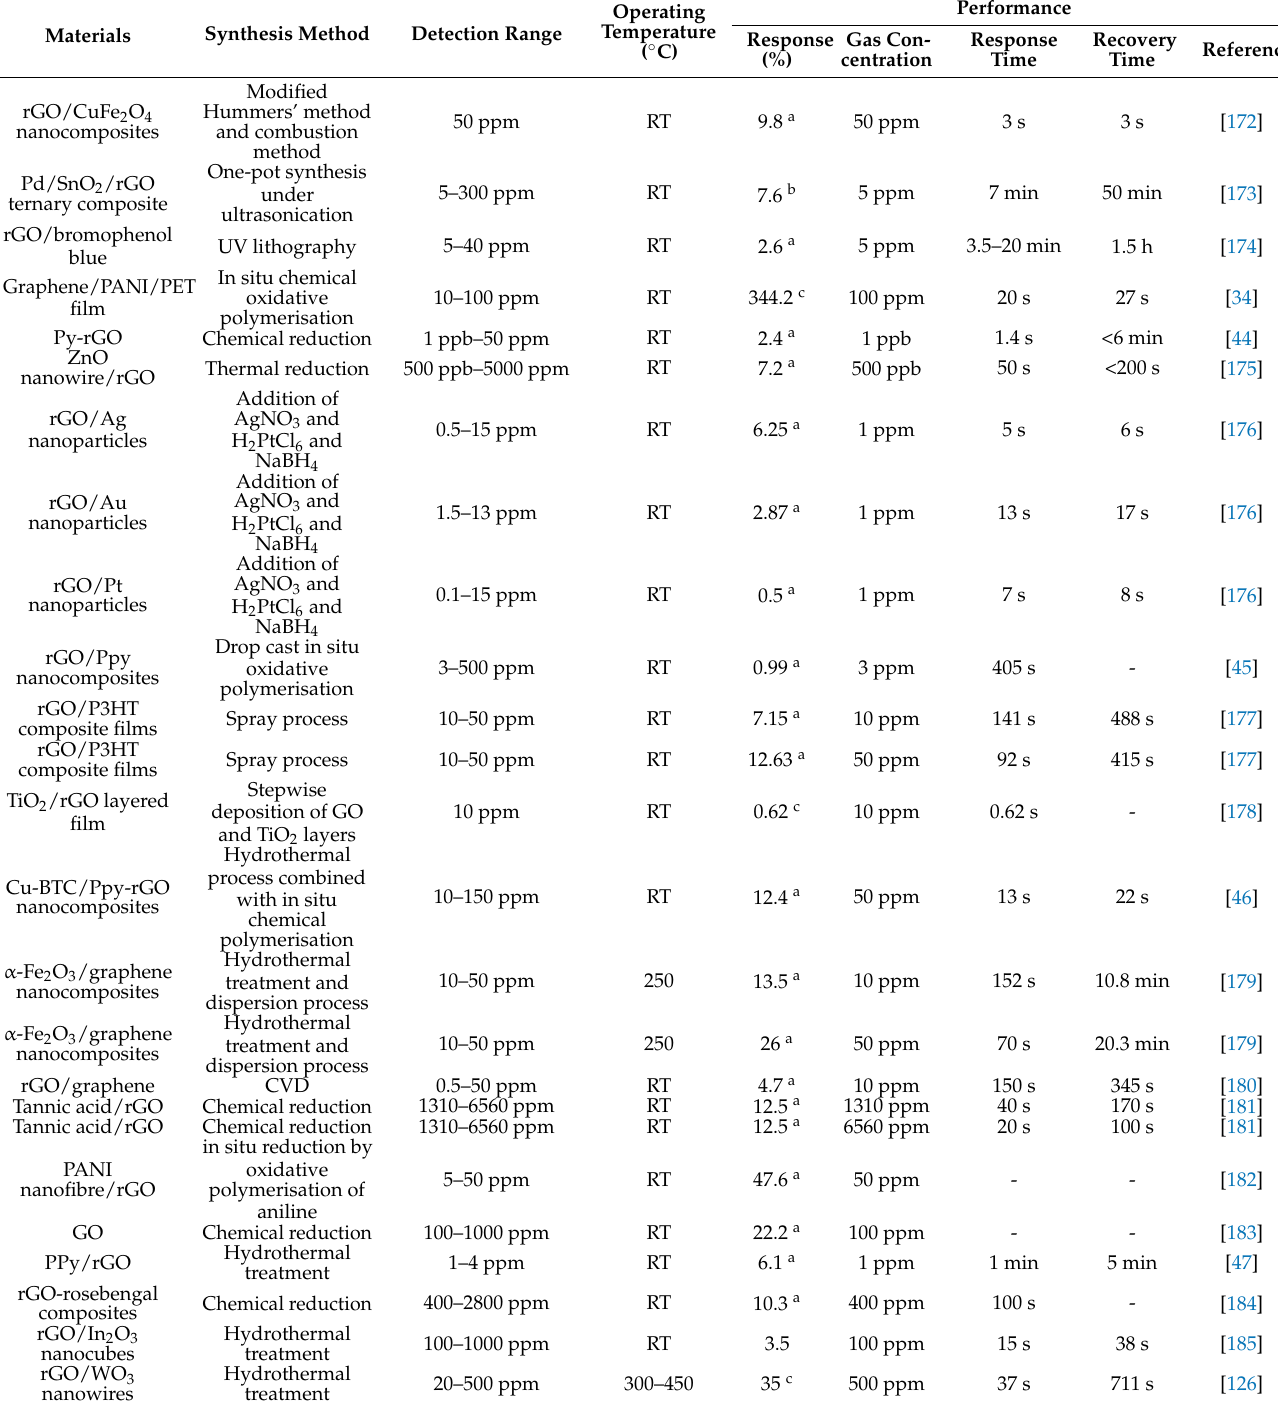
Table 8. Summary of recent works related to graphene-based polymer nanocomposite gas